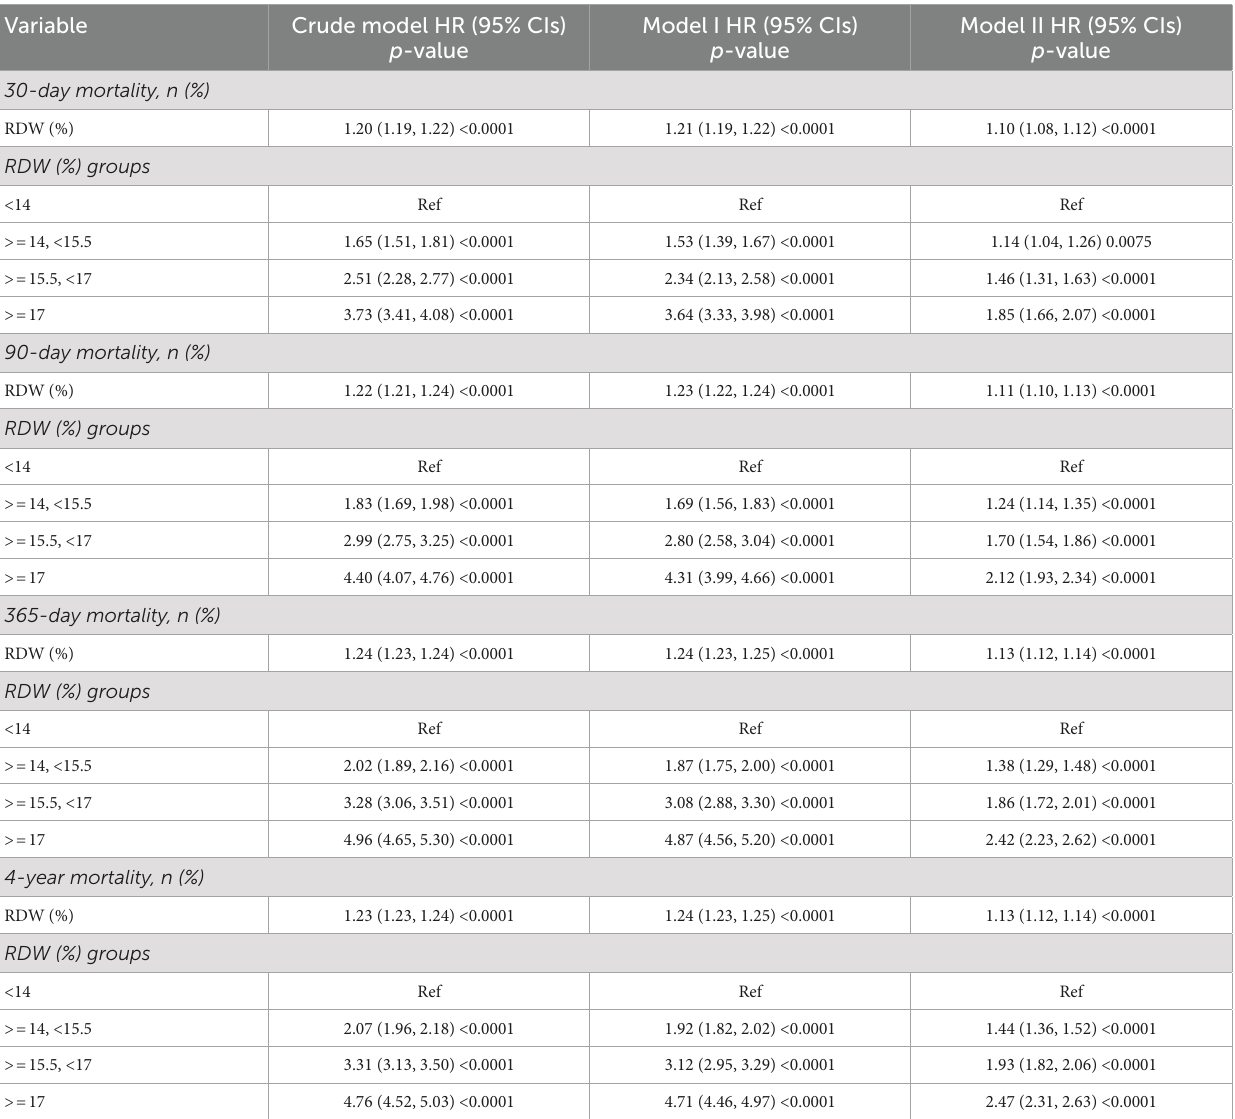
TABLE 2 Association of RDW with